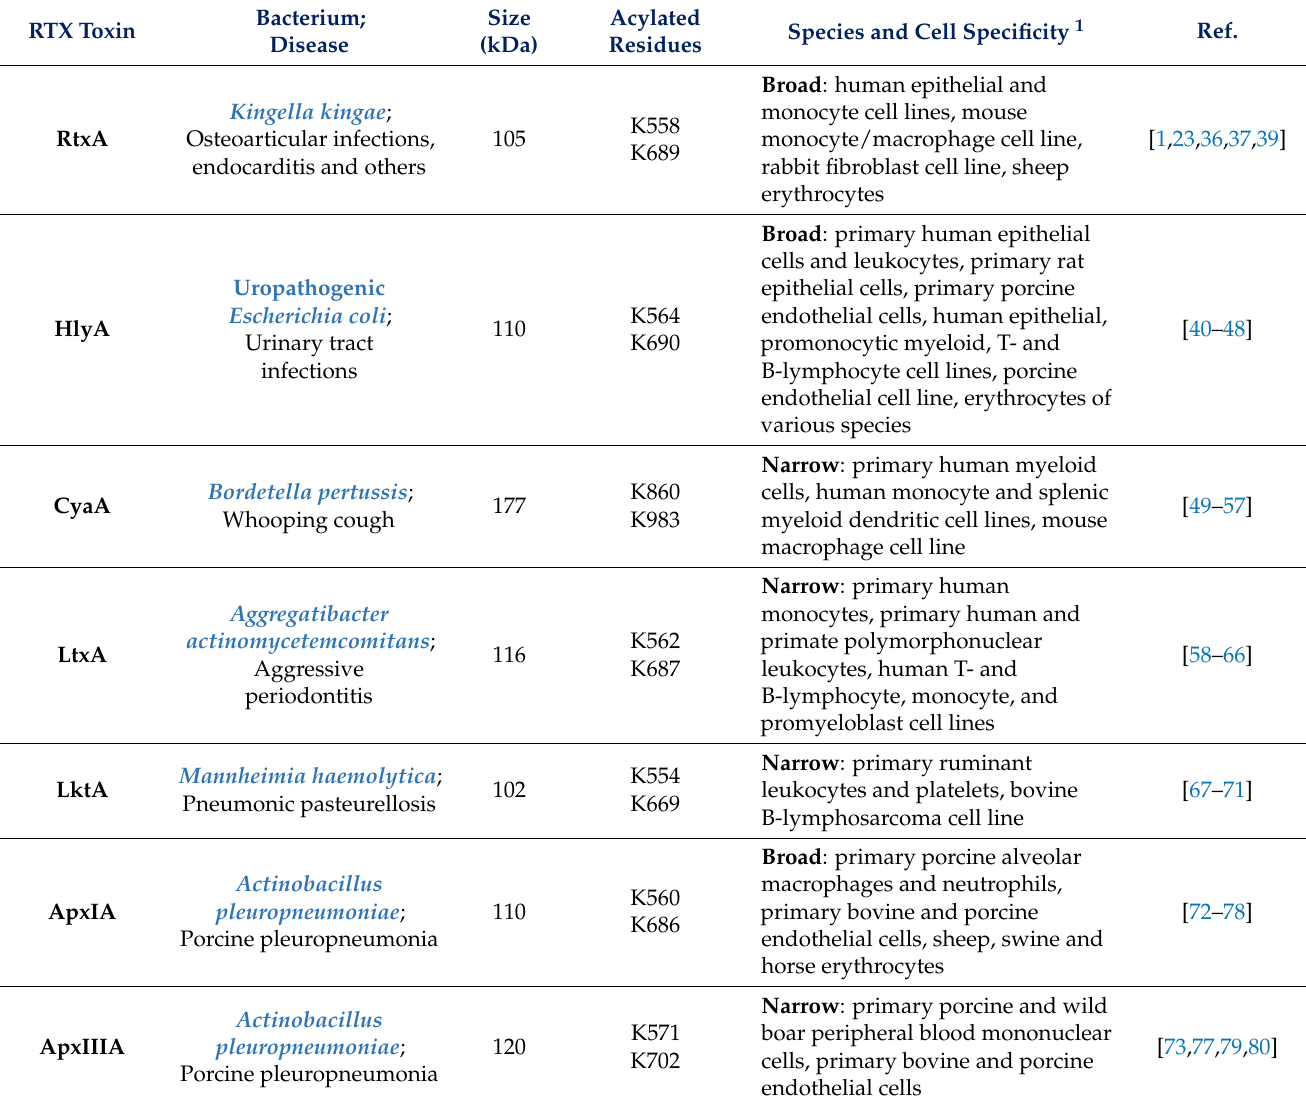
Table 1. General characteristics of RTX toxins discussed in the